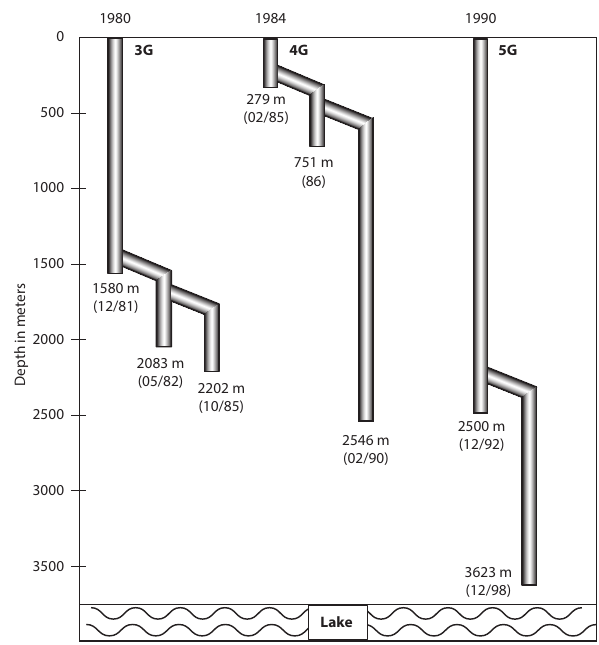
Fig. 4. Deep drilling at the Vostok